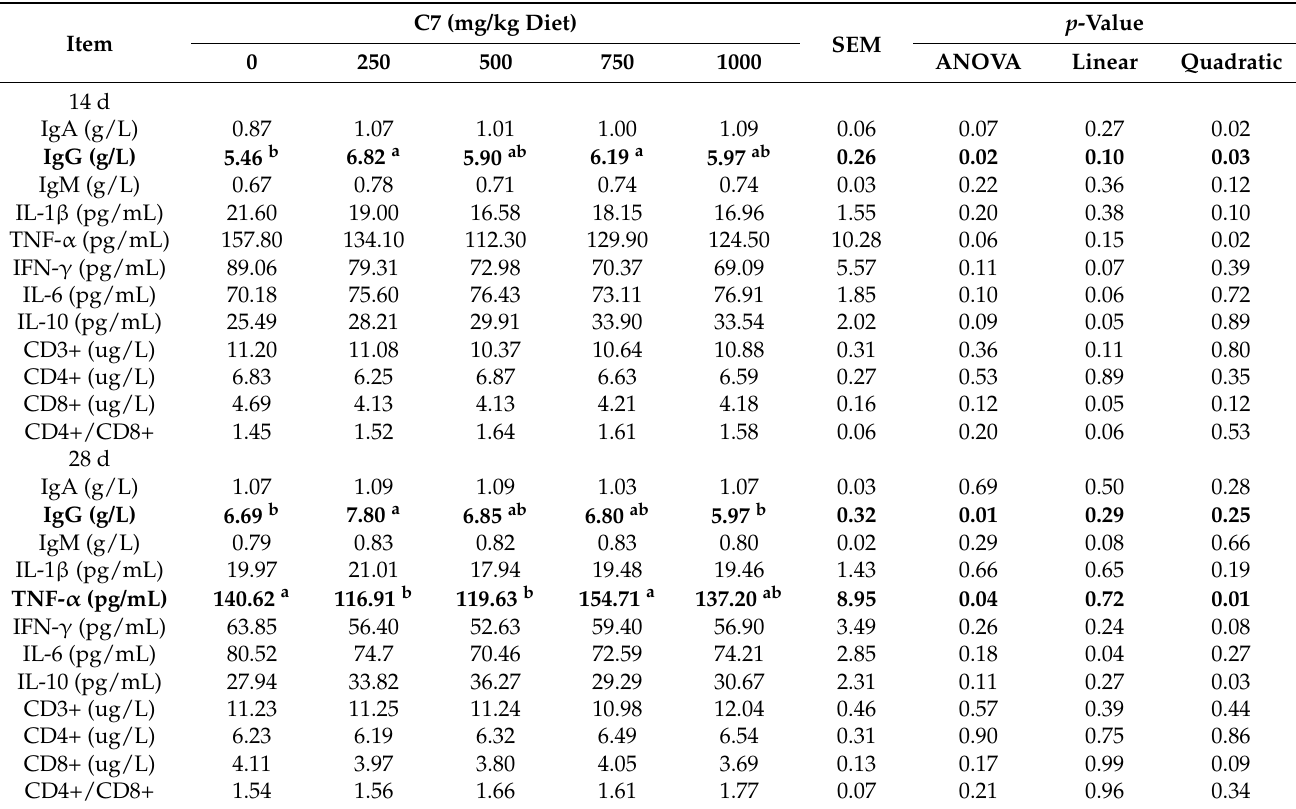
Table 8. Effect of dietary C7 supplementation on serum immune indexes.